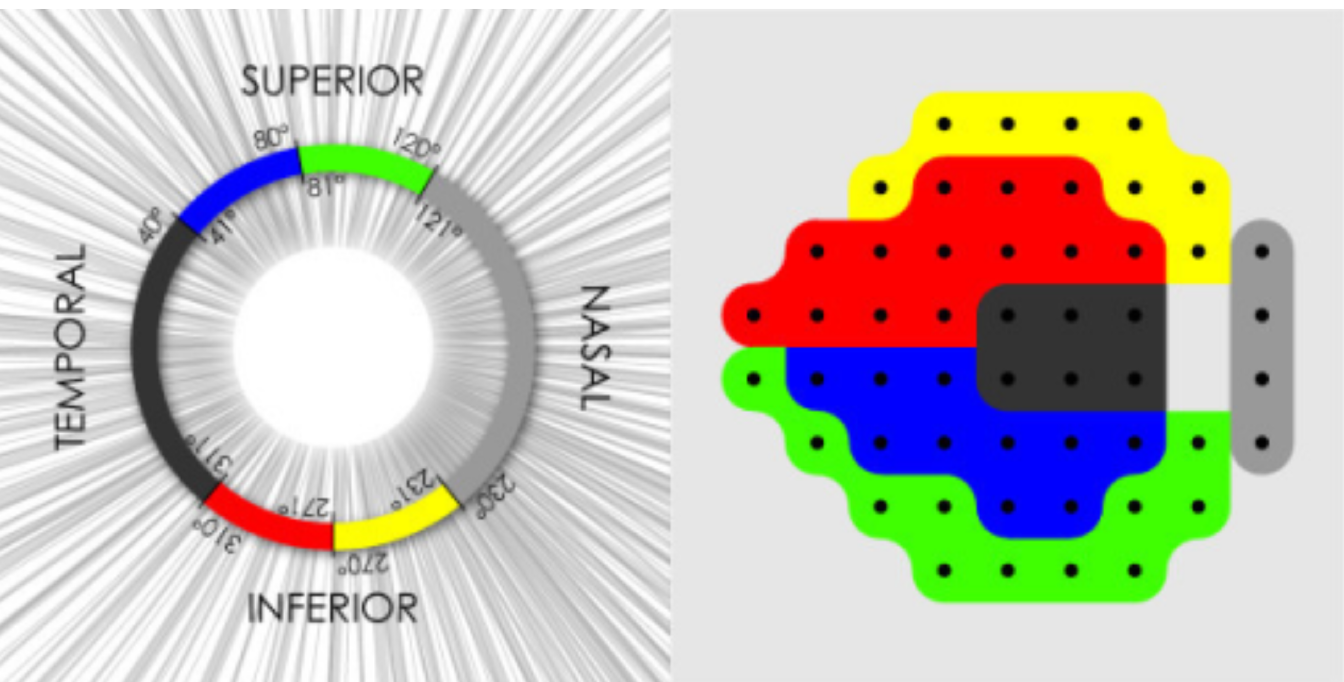
Fig 1. Map representing the relationship between Standard Automated Perimetryvisual field sectorsand sections of the peripapillary OCT scan circle. Bizies D et al. Integration and fusion of standard automatedperimetry and optical coherence tomography data for improvedautomatedglaucoma diagnostics. BMC Ophthalmol 2011; 11: 20 2011Bizies et al; licenseeBio Med Central Ltd. Creative Commons Attribution License (https://creativecommons. org/licenses/by/2.0/).